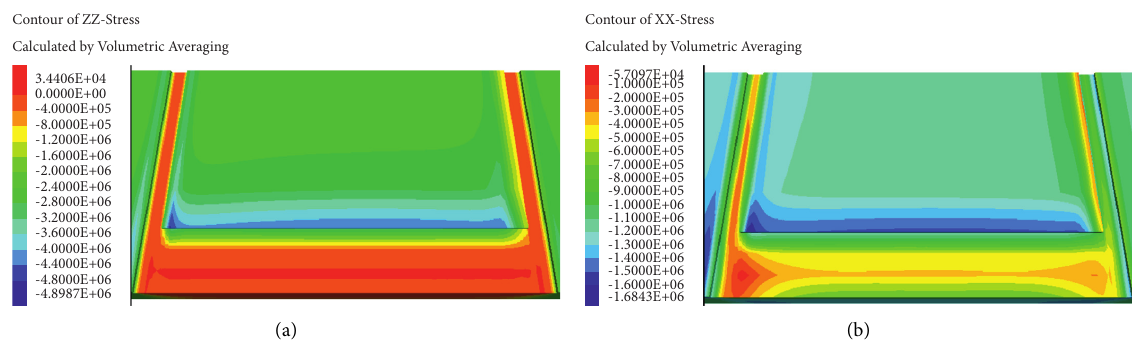
Figure 13: Stress distributions while excavating a face for 15m. (a) Vertical stress. (b) Horizontal